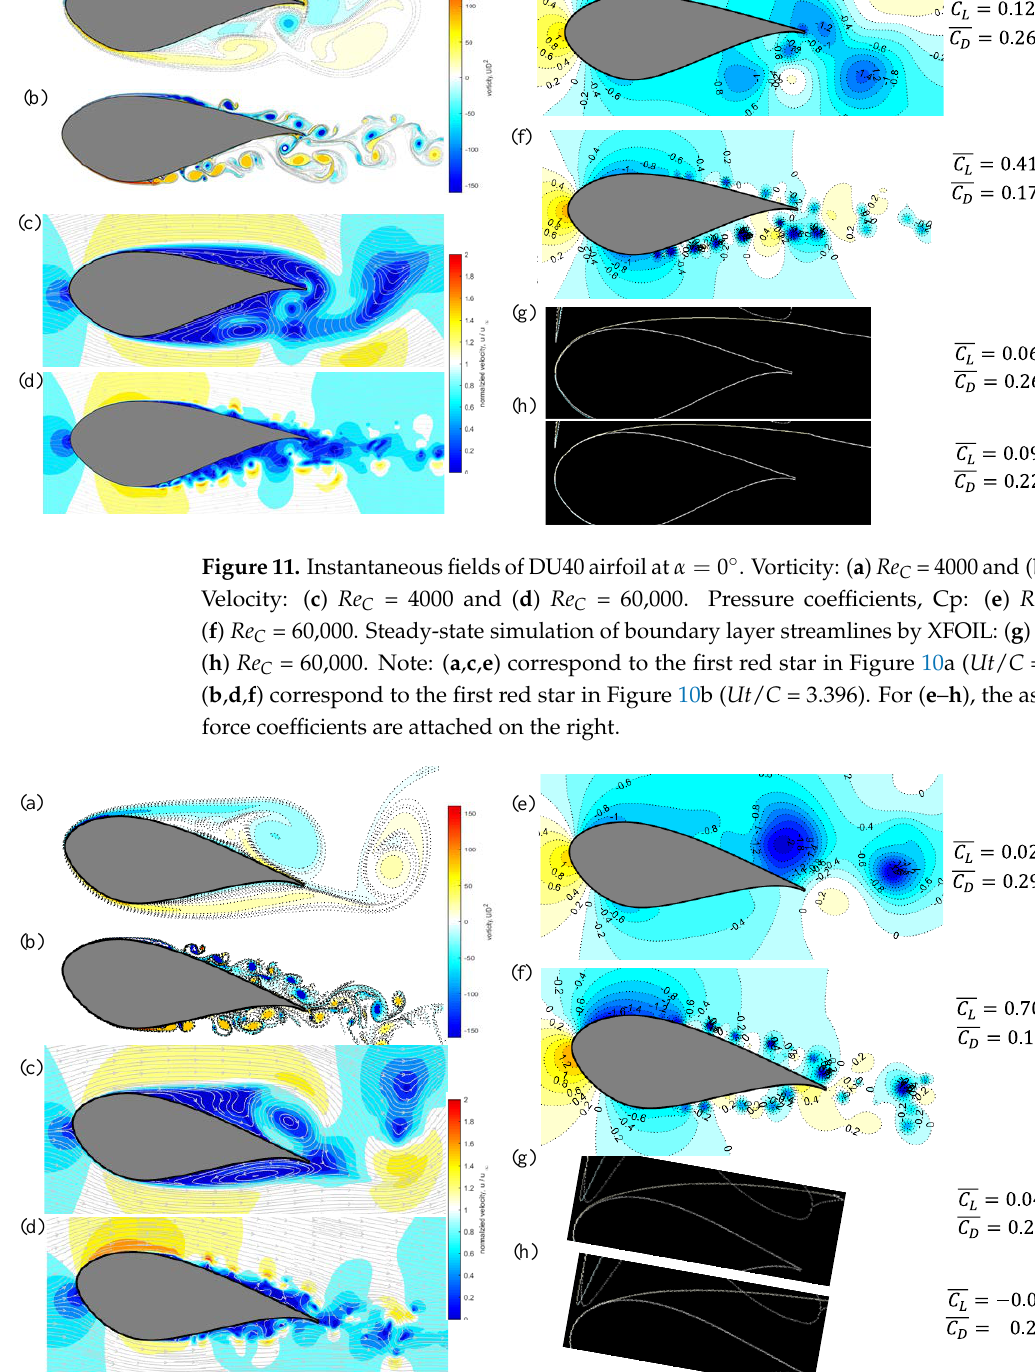
Figure 12. Instantaneous fields of DU40 airfoil at α = 10 ◦ . Vorticity: ( a ) Re C = 4000 and ( b ) Re C = 60,000. Velocity: ( c ) Re C = 4000 and ( d ) Re C = 60,000. Pressure coefficients, Cp : ( e ) Re C = 4000 and ( f ) Re C = 60,000. Steady-state simulation of boundary layer streamlines by XFOIL: ( g ) Re C = 4000 and ( h ) Re C = 60,000. Note: ( a , c , e ) correspond to the first red star in Figure 9b ( Ut / C = 59.315) while ( b , d , f ) correspond to the first red star in Figure 9d ( Ut / C = 3.05). For ( e – h ), the associated mean force The surface pressures at representative instants of the lift history, i.e., the red stars coefficients are attached on the labeled in Figure 10, are shown in Figures 13 and 14 and compared to the XFOIL steady- state solutions. At the low Reynolds number (Figures 13a–d and 14a–d), the upstream portion of the surface pressures remains steady for most of the time while more fluctua- tions can be observed on the leeward surface due to the unsteady wake. The mean value of surface pressures agrees with the XFOIL steady-state result in low-Reynolds number flow. For the high Reynolds number flow (Figures 13e–h and 14e–h), significant pressure fluctuations caused by flow separation and the roll-up vortices can be observed on the downstream portion of the surfaces. Sudden drops of the mean suction can be observed in 0.4 < x / C < 0.6 on both the upper and lower surfaces. At α = 0° , XFOIL simulations indicate that pressure recoveries occur at x / C = 0.6 and 0.5 on the upper and lower sur- faces, respectively, which agree with the instantaneous pressures obtained from VPM. For the higher angle of attack, α = 10° , both XFOIL and VPM show that the upper surface pressure recovery point moves upstream to about x / C = 0.42 but disagree on the lower surface recovery point (VPM gives about x / C = 0.5 while XFOIL gives x / C = 0.62). For both angles of attack, VPM simulations give higher upper surface suctions than the XFOIL re- sults on the surface upstream to the pressure recovery point. However, after the pressure recovery, VPM gives lower suctions.